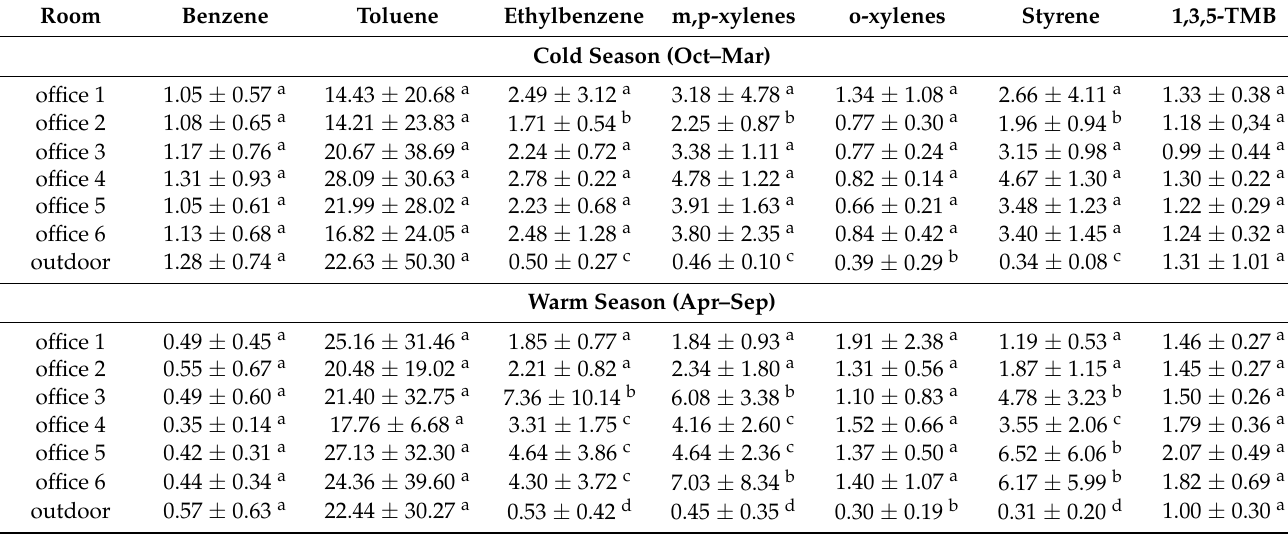
Table 2. Mean and standard deviation (Mean ± SD, µ g/m 3 ) for VOCs in offices and outdoors, cold (Oct–Mar) and warm (Apr–Sep) season.